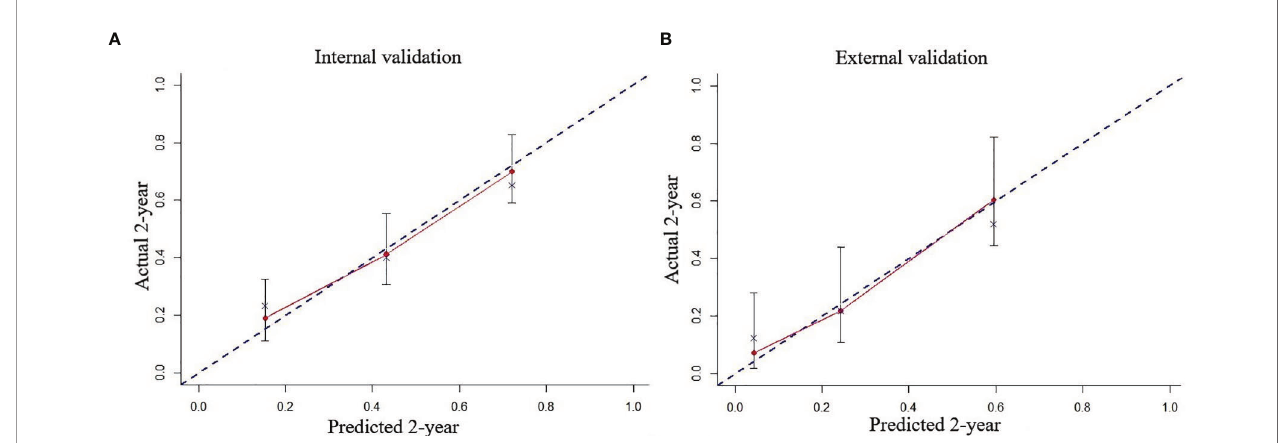
FIGURE 5 | The predicted probability of 2-year OS by HHLWG-HPI was plotted on the x ‐ axis, and the actual 2-year OS was plotted on the y ‐ axis in internal (A) and external